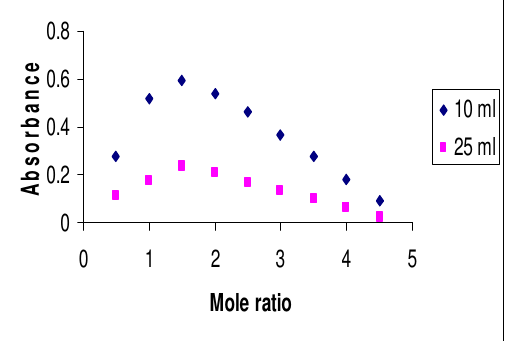
Figure 2 . Determination of stoichiometry and stability